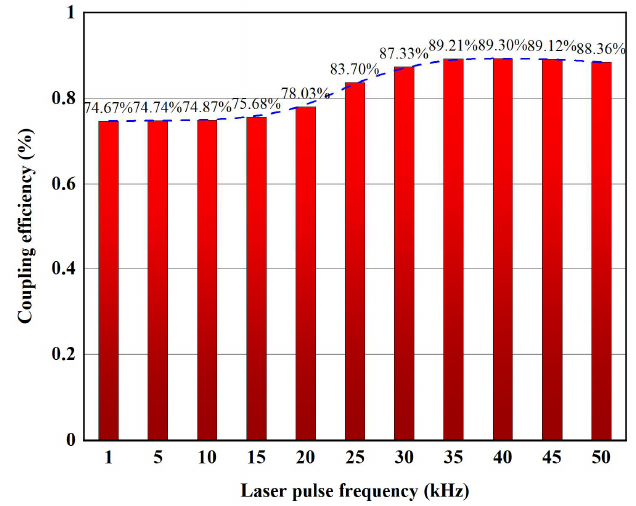
Figure 5. The coupling efficiency of the laser and waterjet.